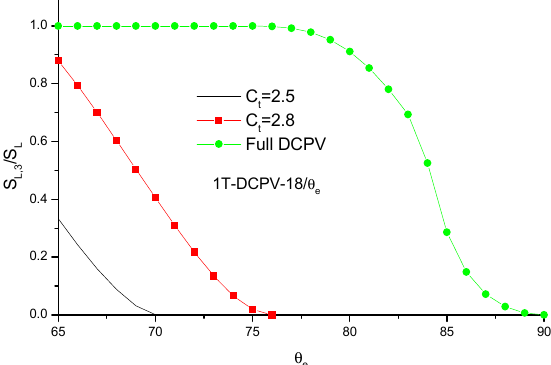
θ θ for 1T-DCPV-18/ e .